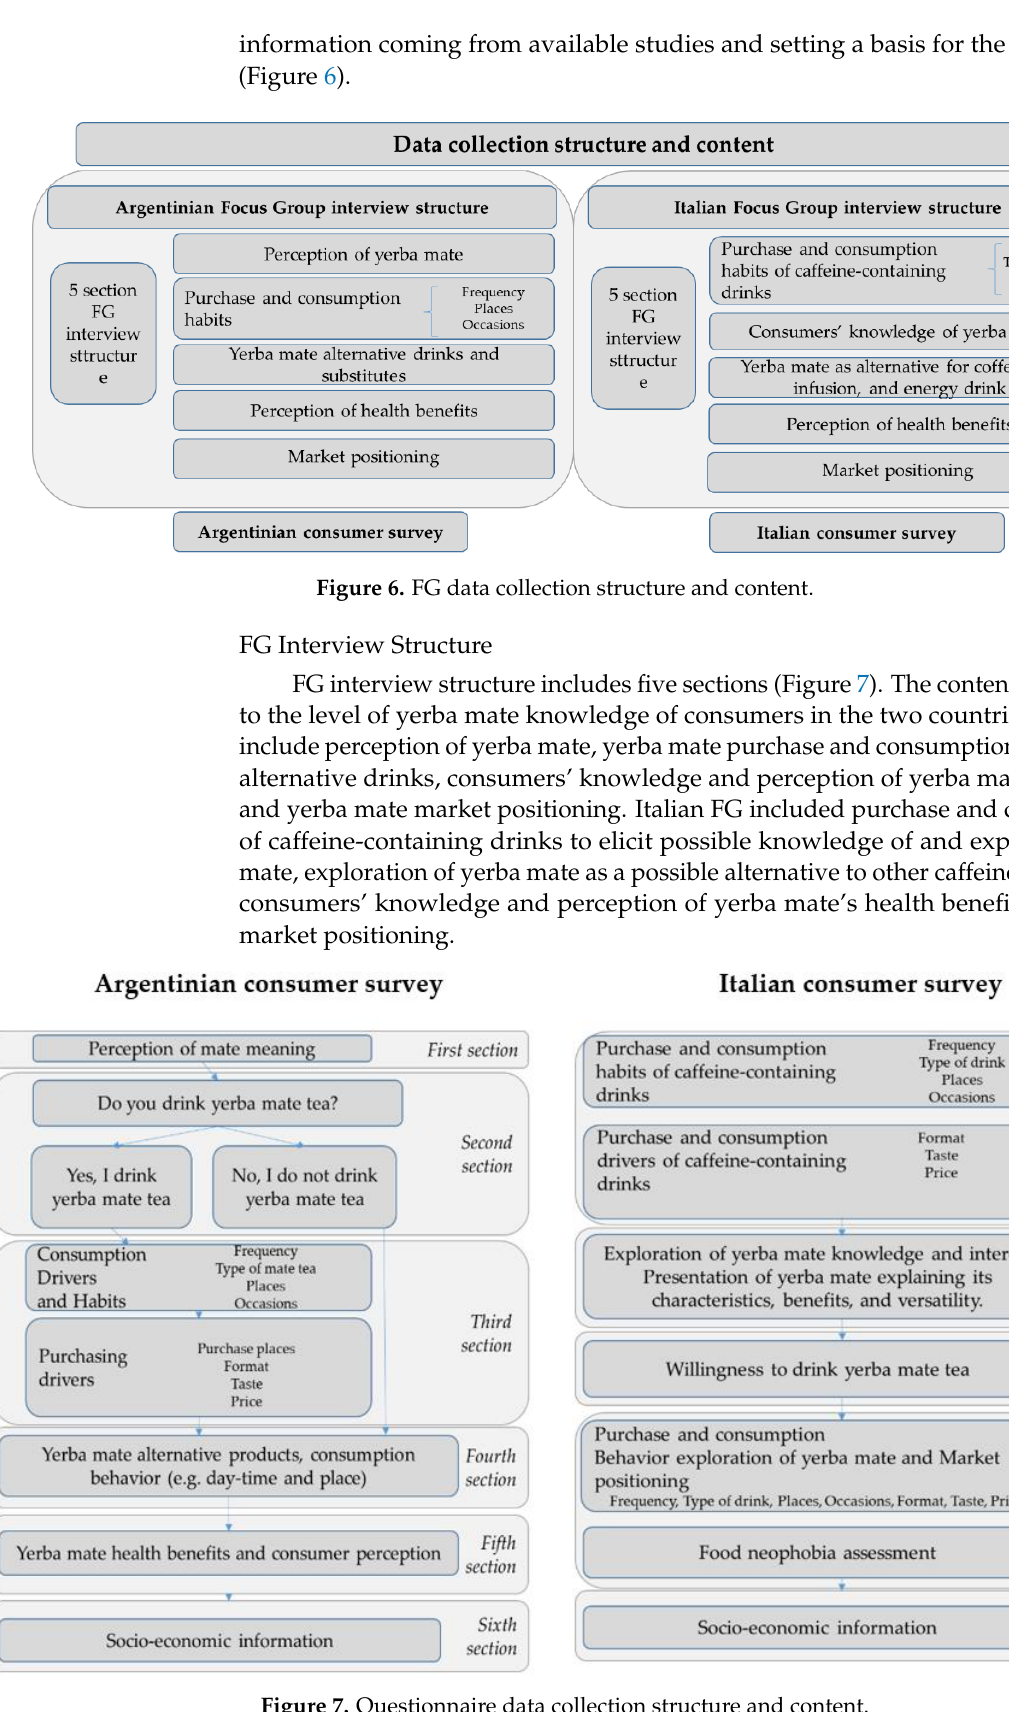
Figure 8. Yerba mate purchasing driving factors.